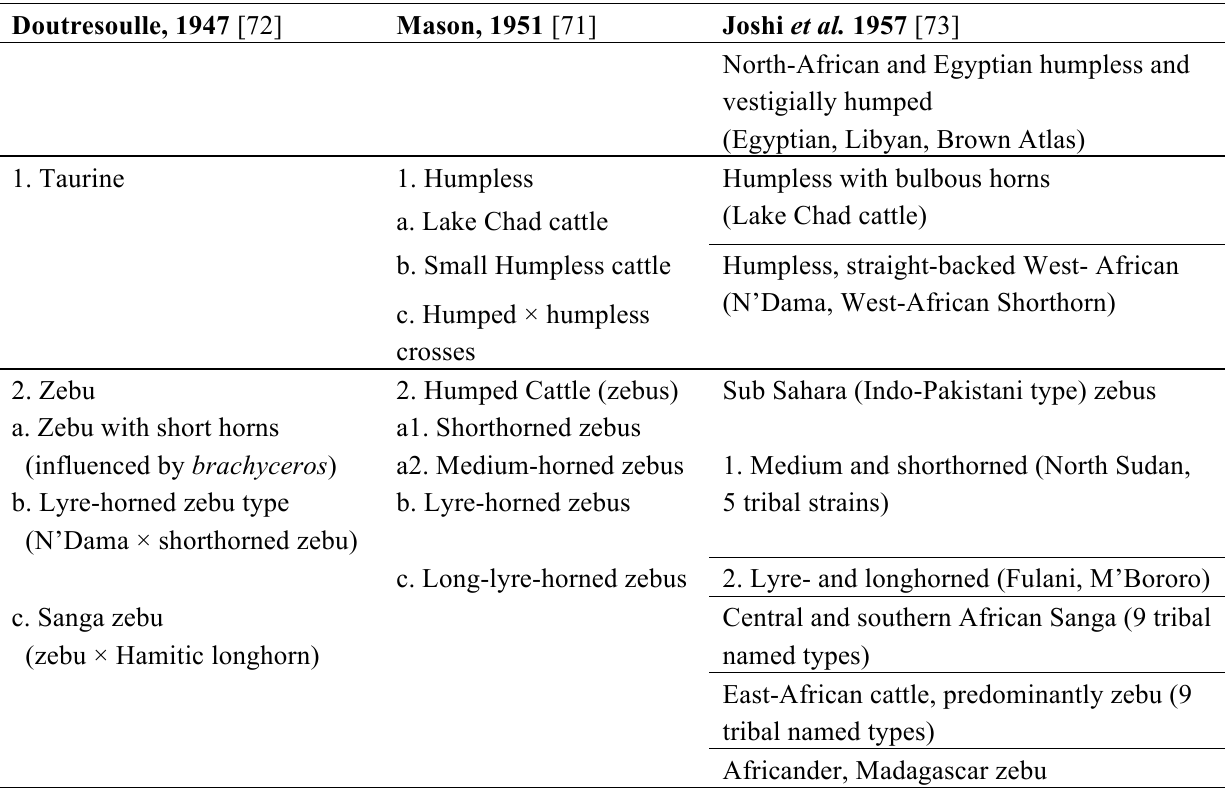
Table 2. Classification of African types and